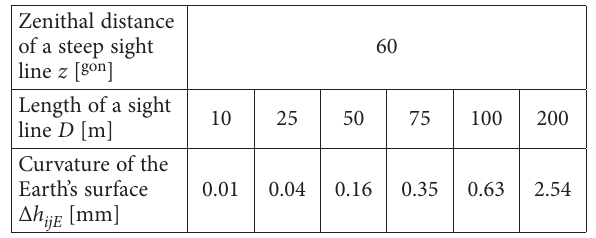
Table 1. Curvature of the Earth’s surface depending on the length of the sight line